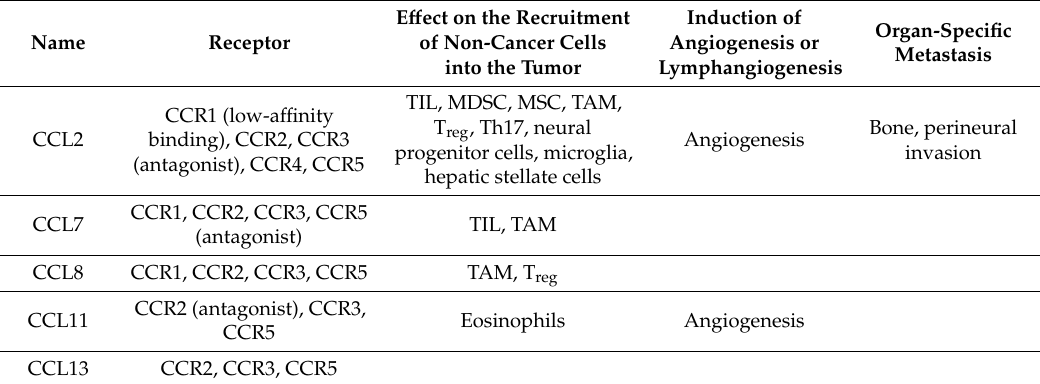
E ff ect on the Recruitment of Non-Cancer Cells into the